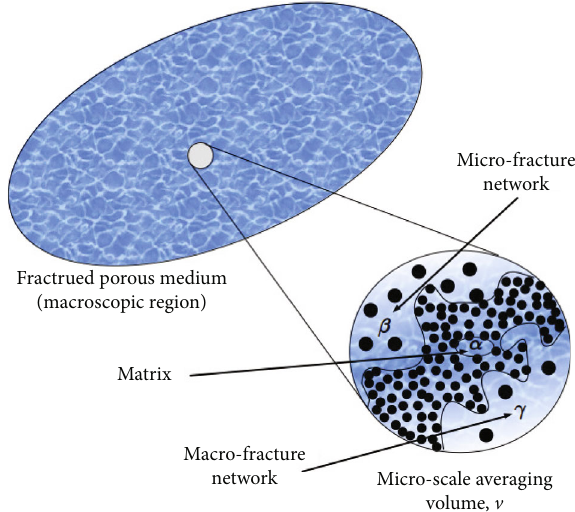
Figure 3: Fractured reservoir model: a macroscopic region and an averaging volume